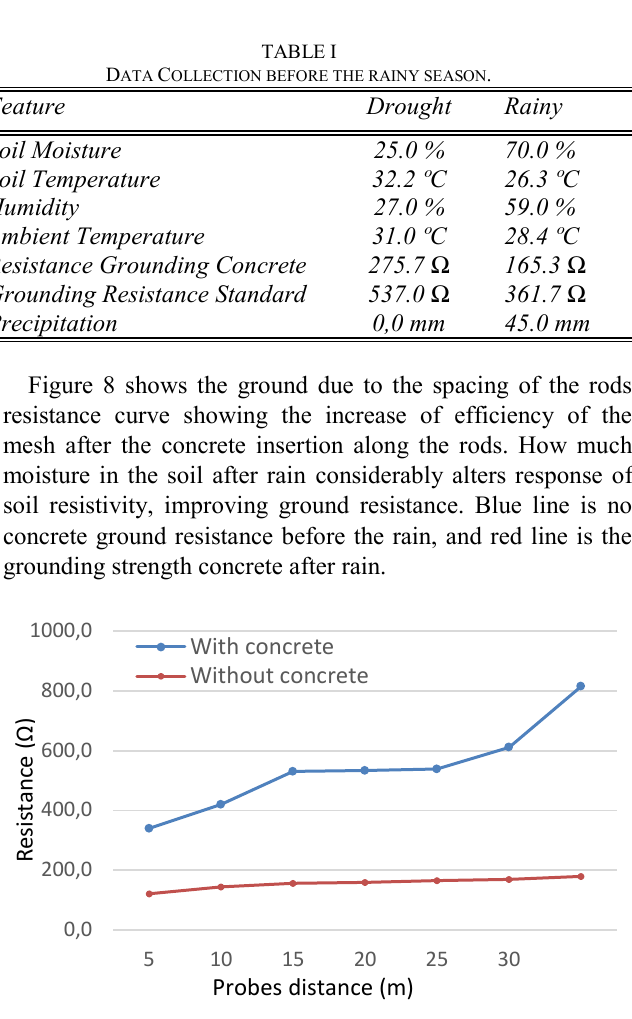
Fig. 7. Chart show grounding resistance at end of dry season in relation to distance from stems using Werner method.